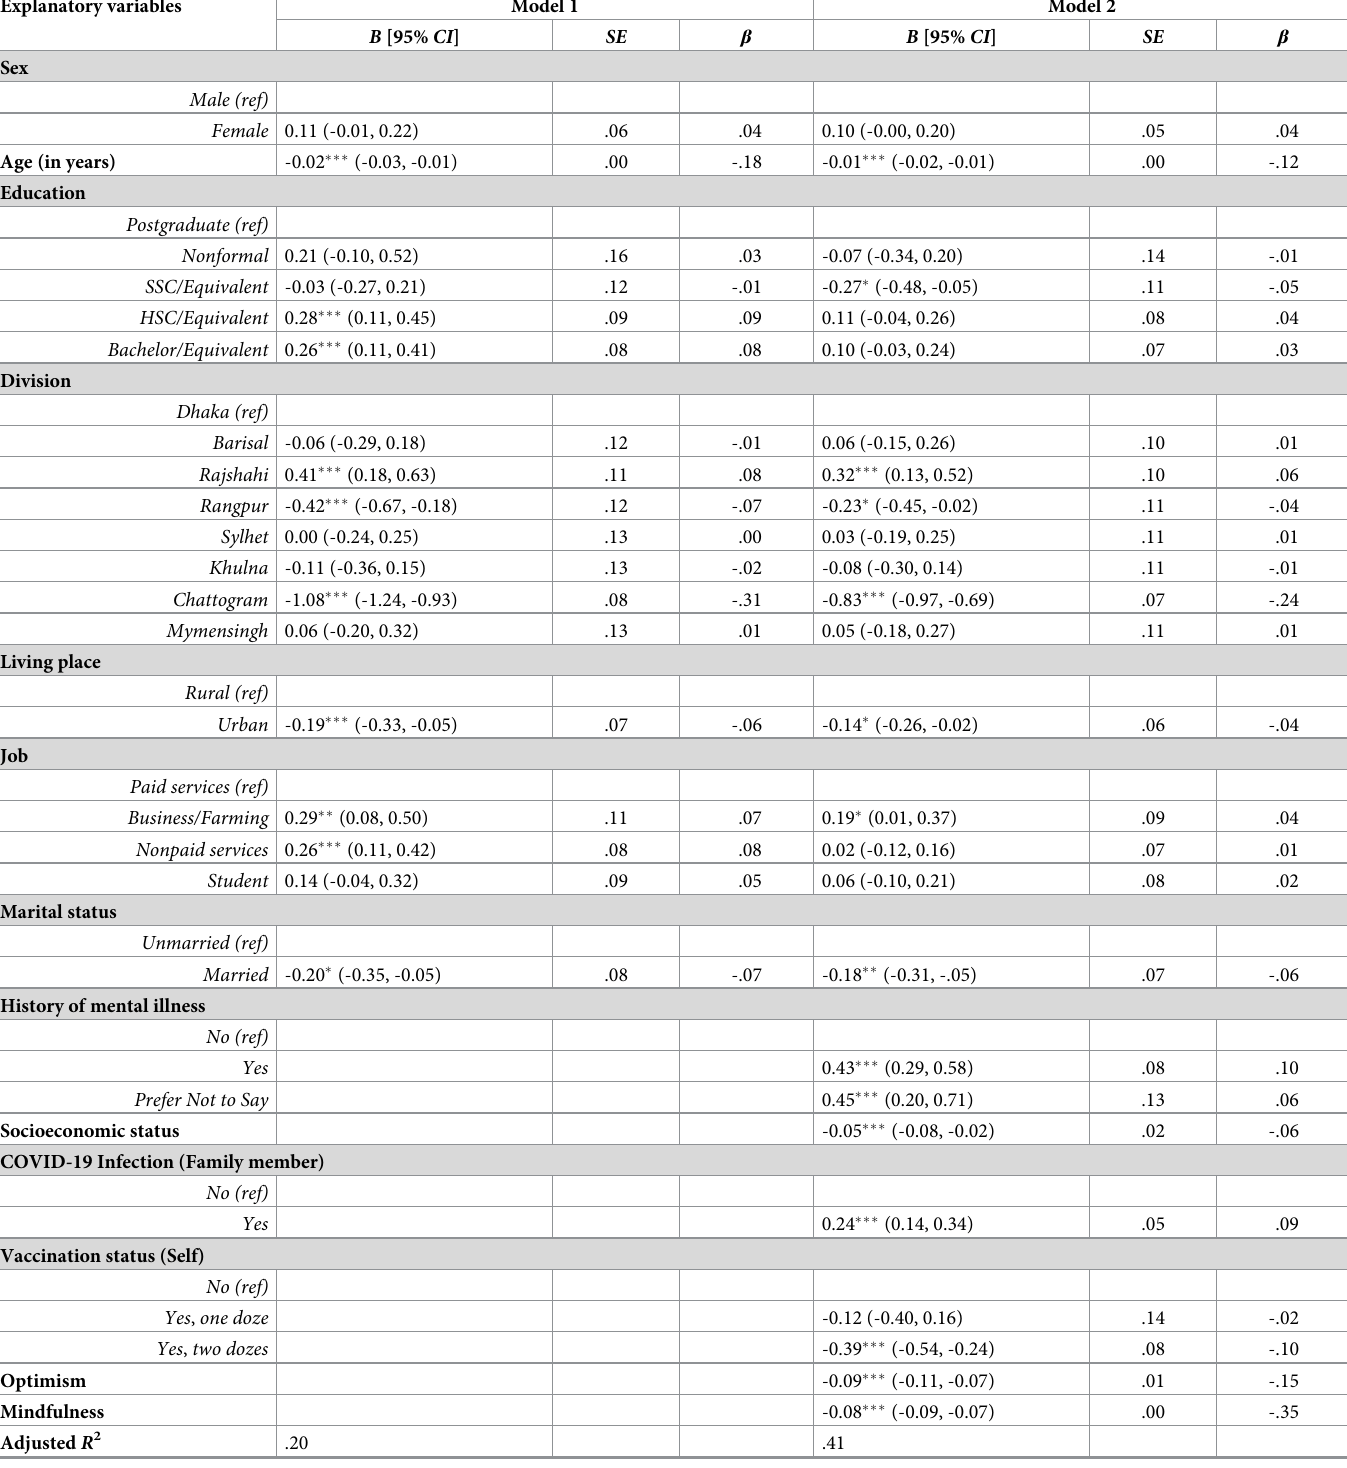
Table 4. Nonmodifiable and modifiable factors associated with depression among Bangladeshi adults ( N = 1897). Explanatory